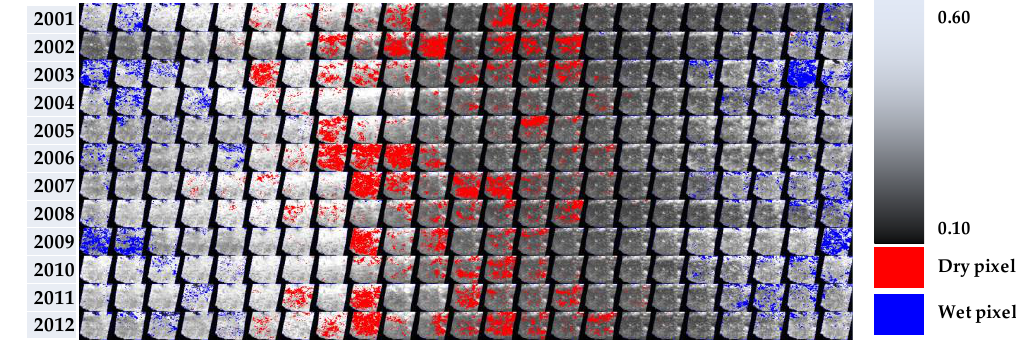
Figure 8. Dry and wet pixels (shown in red and blue, respectively) selected through the regions of interest (ROYs) buffering the two edges in the NDVI vs. Δ LST features space over-imposed to the time-domain mosaic of NDVI (in greyscale).